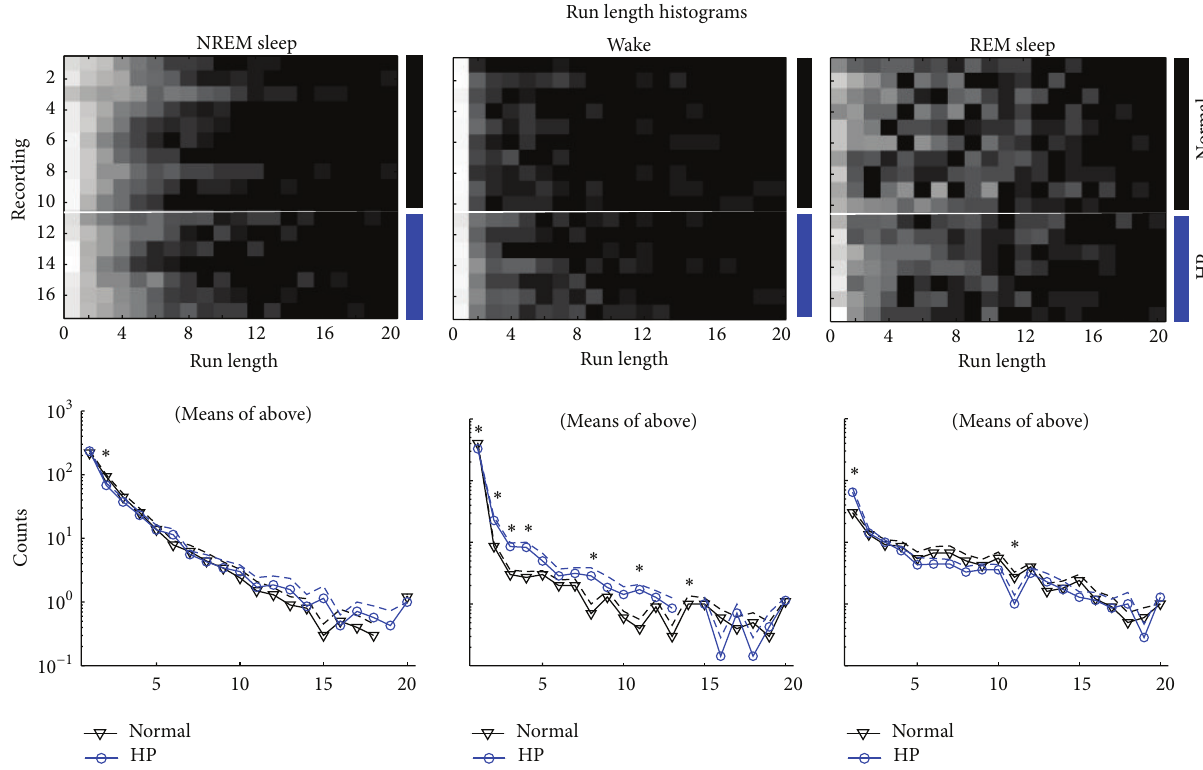
Figure4:Runlengthcomparison.Top:rows1–10showrecordingsfrom10normalrats(1recordingfromeachrat).Rows11–17showrecordings from 5 HP rats (rows 11-12 and rows 13-14 show consecutive 24-hour periods from two HP rats, resp.). Columns show the run length (i.e., shorter run lengths on the left and longer run lengths on the right). Bottom: means (solid) and standard errors (dashed) of the top histograms showing normal (black triangles) and HP (blue circles). Missing data points on the log plots represent a mean of zero.